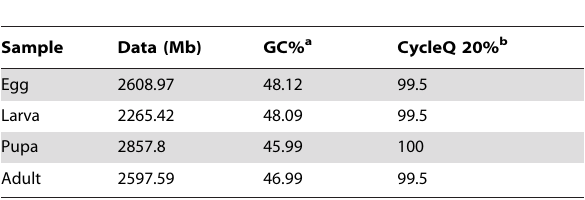
Table 1. Summary for raw reads of four samples.